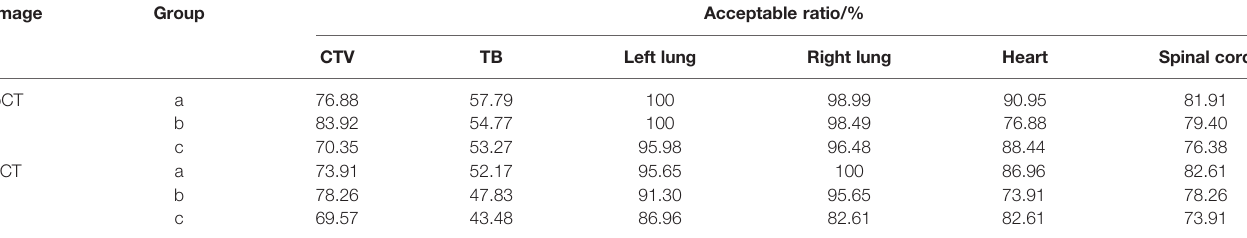
TABLE 4 | Acceptable ratio for automatic delineation among different groups. Image